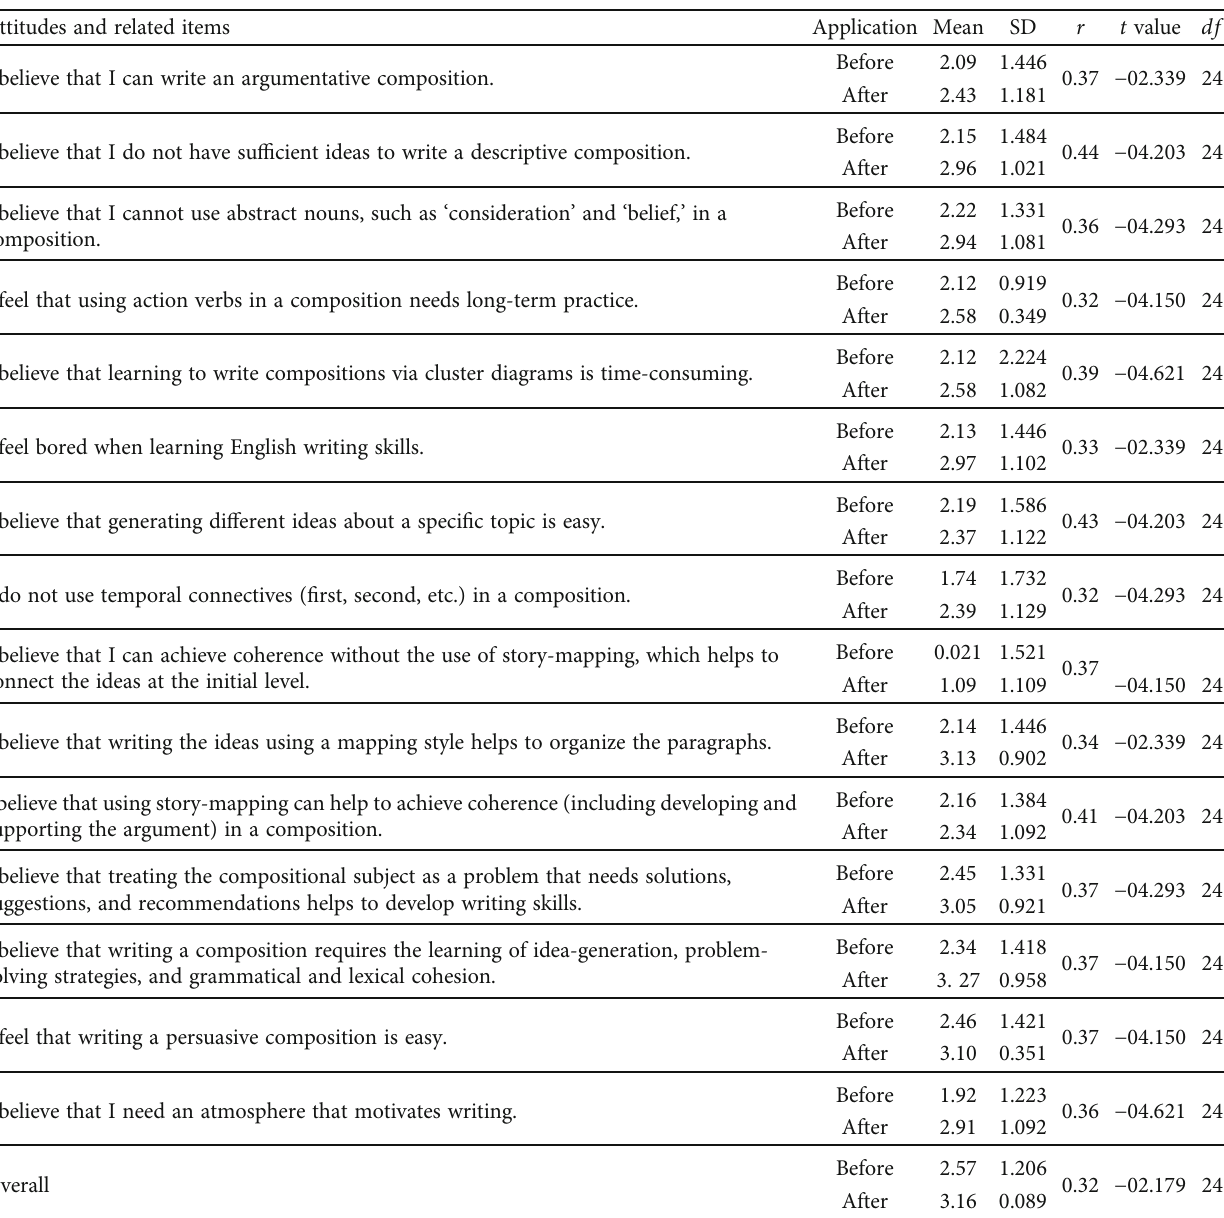
Table 5: The means and standard deviations of pre- and postattitudes towards writing in